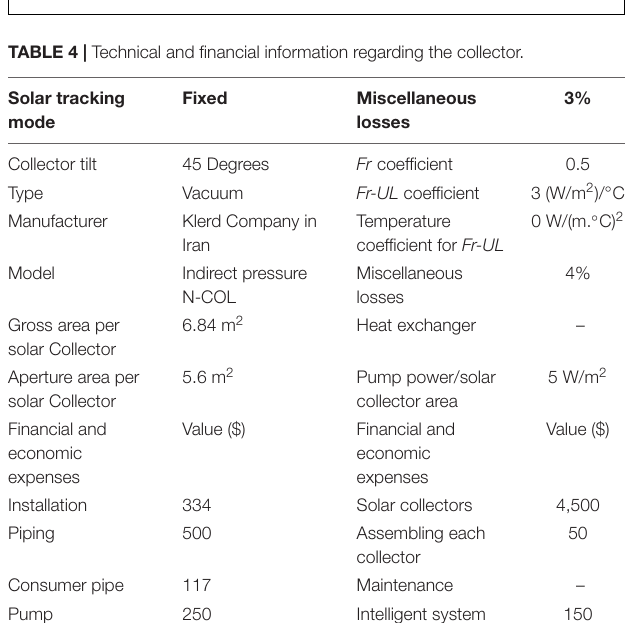
FIGURE 1 | Distribution of pool usage during different months of the year.